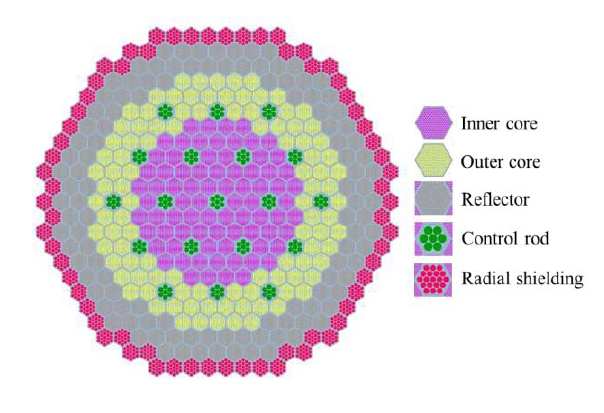
Figure 4. ABR-1000 Radial Core Layout